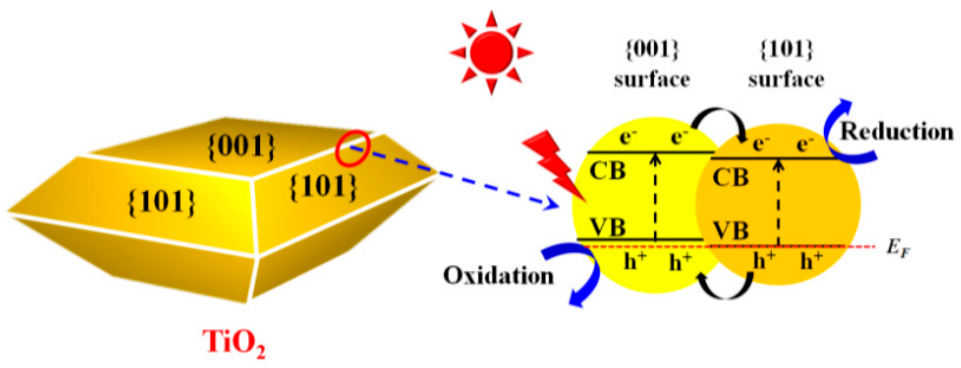
Figure 11. Surface atomic structures of the {110} crystal facet [10]. Reprinted with permission from ref. [10].